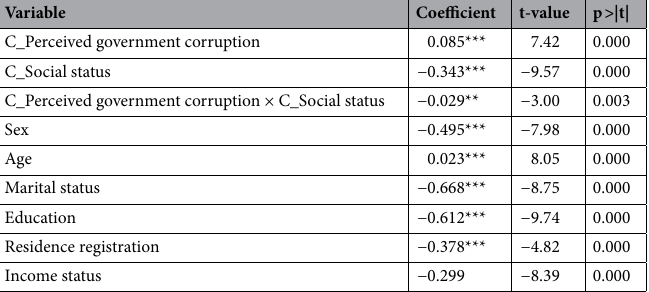
Table 9. Robustness test results (N = 14,116). ***p < 0.01, **p < 0.05, *p <